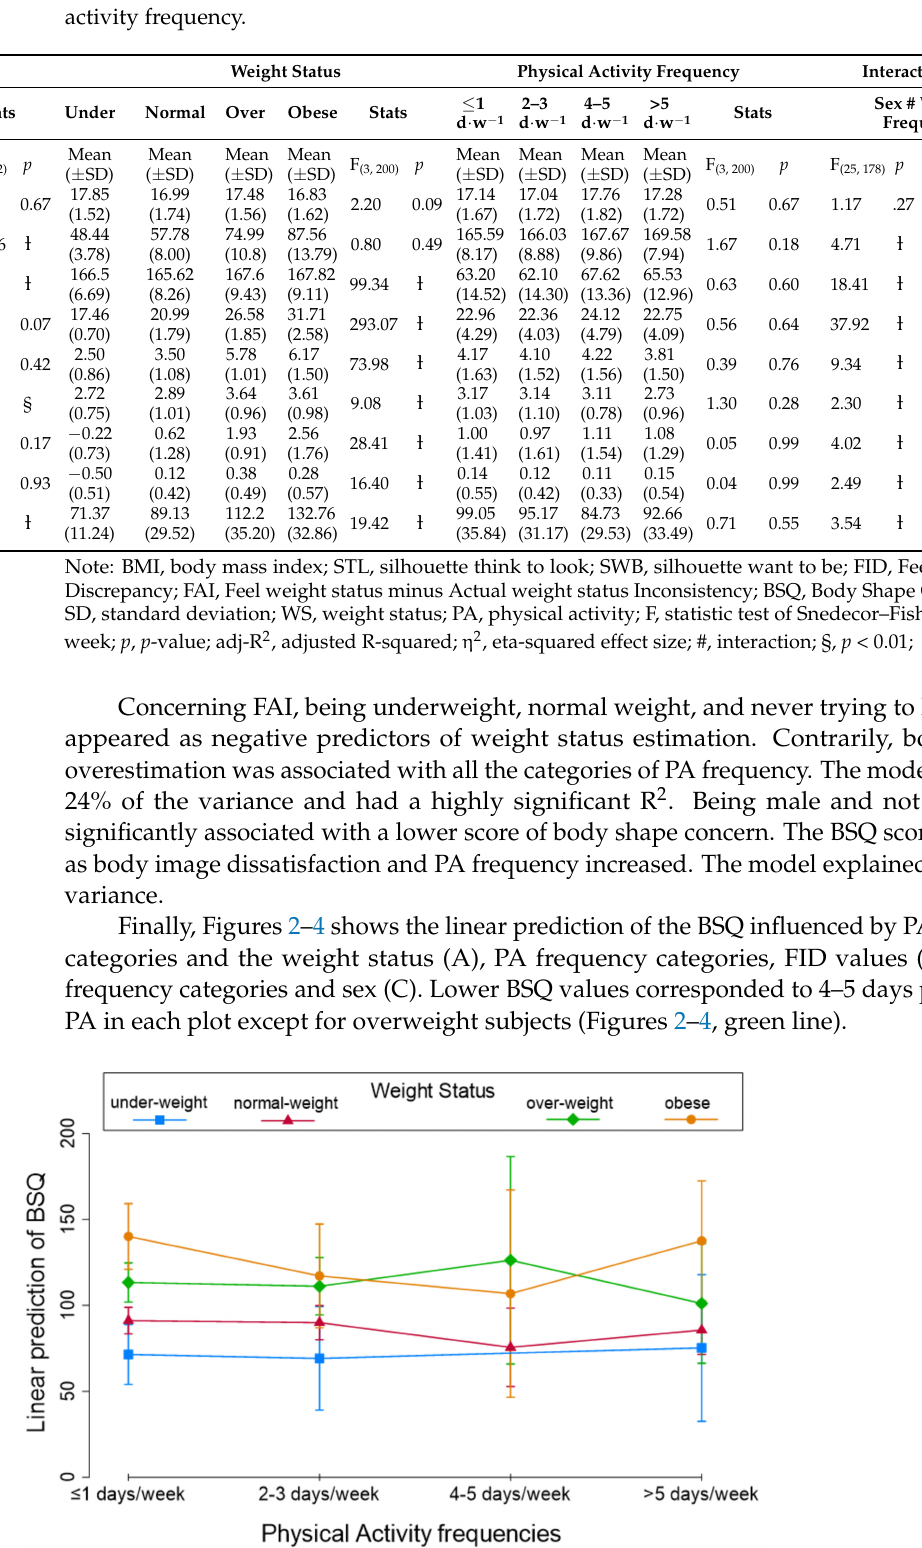
Table 3. Predictors of FID, FAI, and BSQ: multiple regression analysis results.